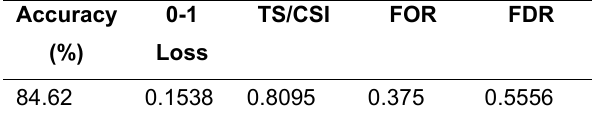
Table 2. Results of KNN